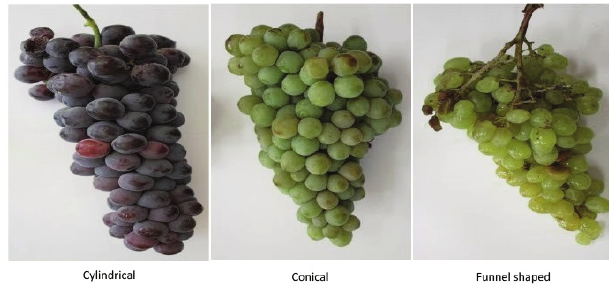
Fig. 3 ­ Example of variability of bunch